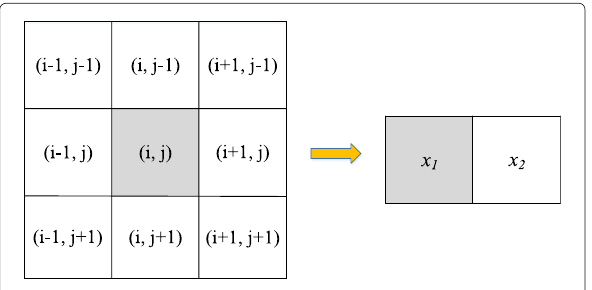
Fig. 2 A pixel and its eight